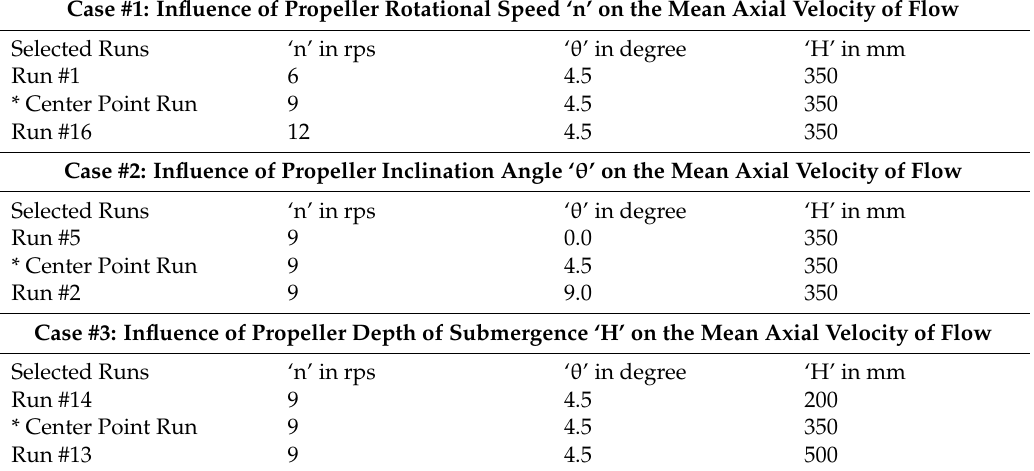
Table 3. Combinations of factors under each case to assess the individual effect of